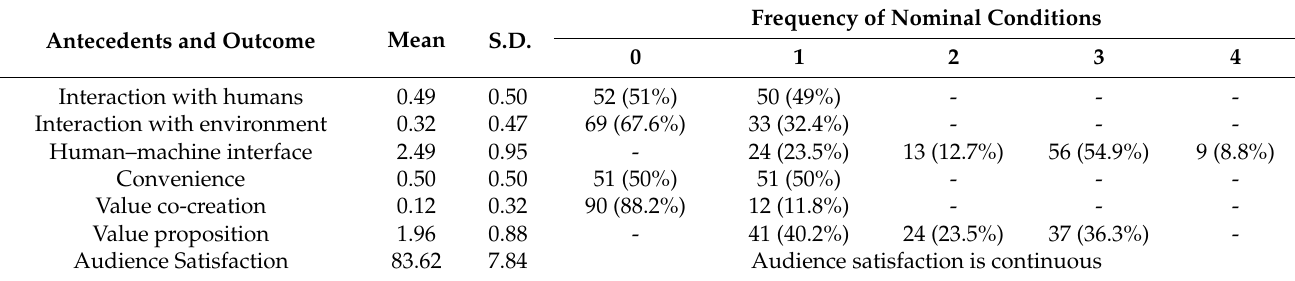
Table 3. Descriptive statistics and frequency of nominal conditions.